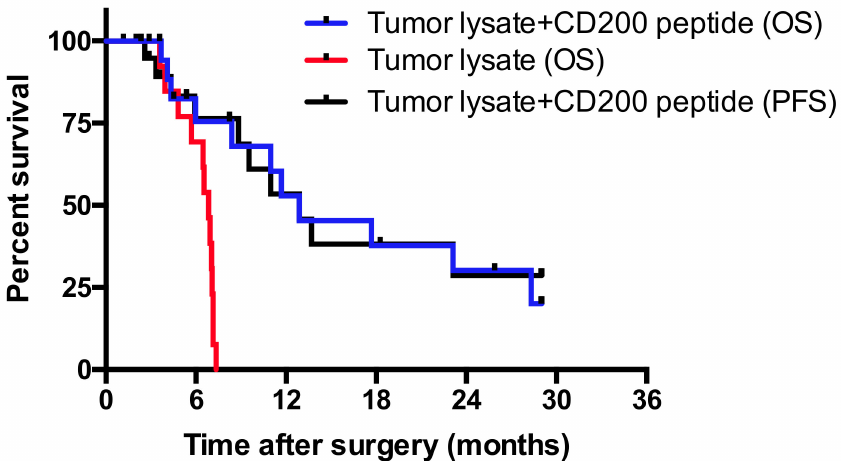
Figure 2. Treatment with the CD200 inhibitor extends progression free and overall survival in dogs. Following surgical resection of the tumors, serial vaccinations of autologous tumor lysate and canine-specific CD200AR-L were administered to each dog. Disease status was followed using magnetic resonance imaging (MRI) and calculated progression-free (black line) and overall survival (blue line) times were significantly longer than a cohort of dogs treated with tumor lysate alone after surgery (red line) ( p = 0.0001). Ticks represent censored cases because the dog is still alive ( n = 3) or had no evidence of disease on postmortem examination of the brain ( n =